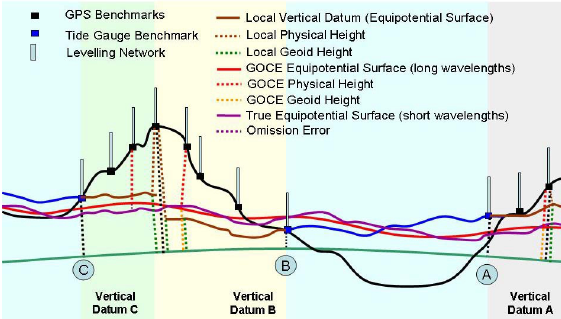
Figure 1. Overview of local height systems and related equipotential surfaces.